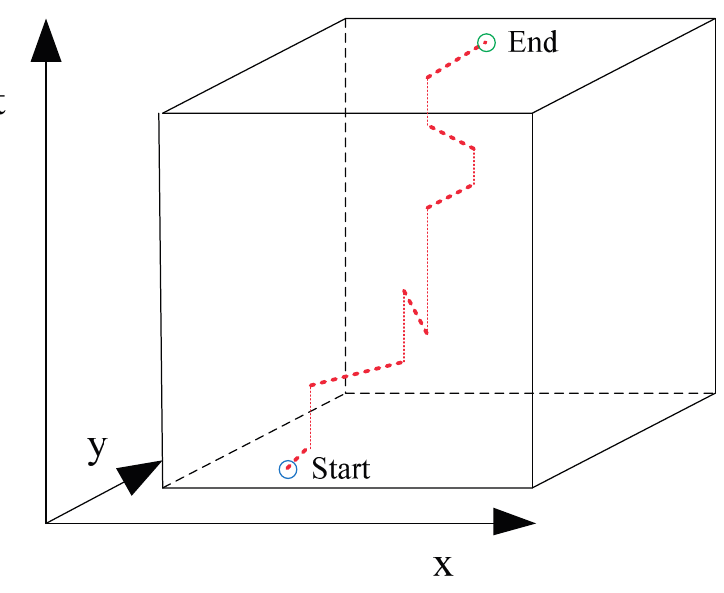
Figure 2. A space-time path in a time geography space-time